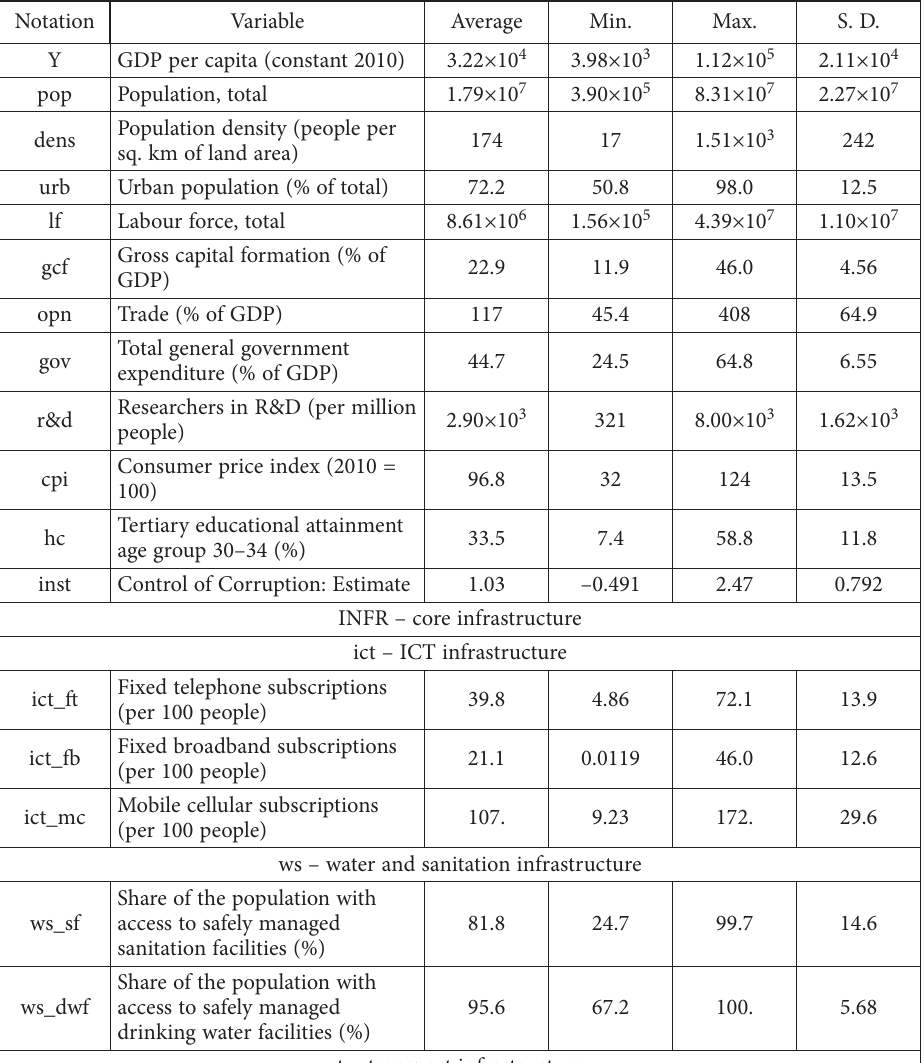
Table 1. Research variables and summary